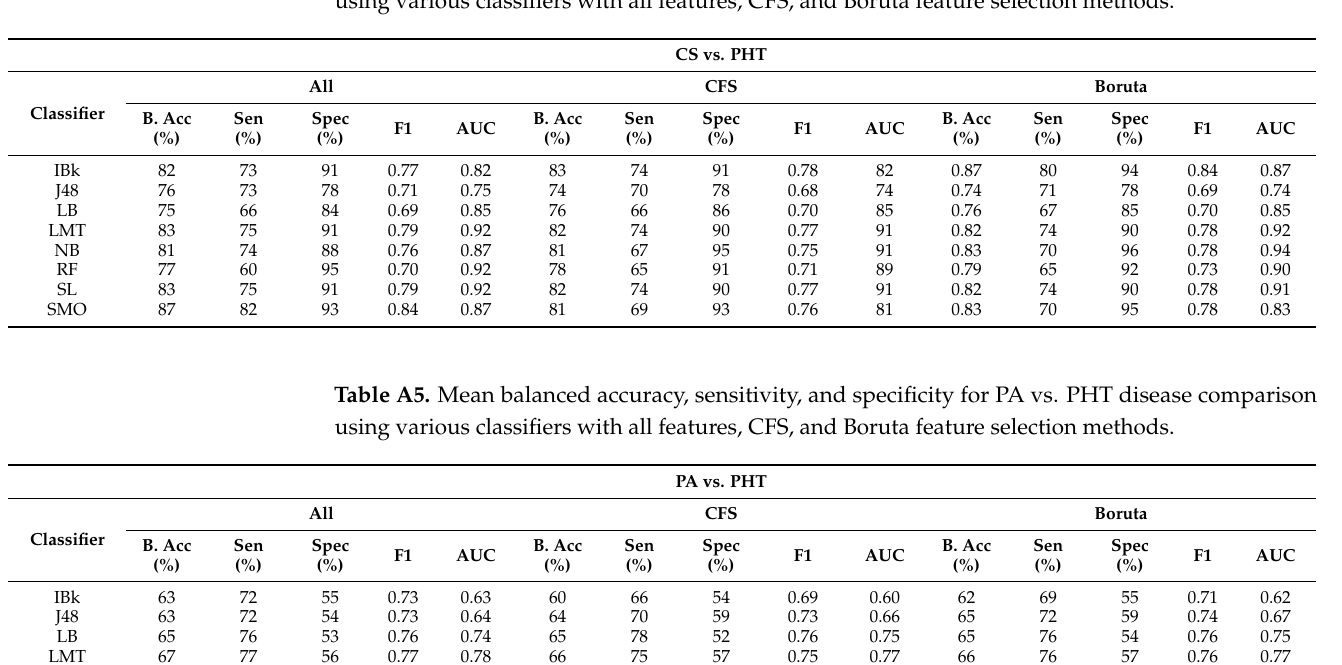
Table A4. Mean balanced accuracy, sensitivity, and specificity for CS vs. PHT disease comparison using various classifiers with all features, CFS, and Boruta feature selection methods.